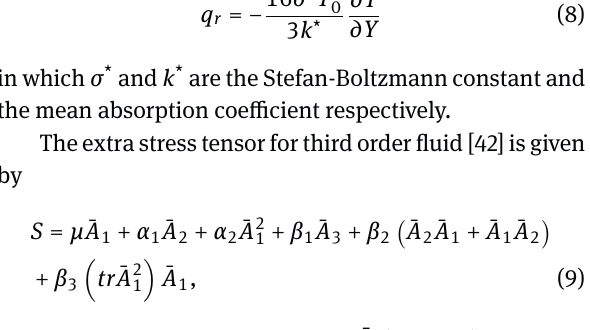
where μ is the dynamic viscosity , ¯ A i ( i = 1, 2) are Rivlin Ericksen tensors and α i ( i = 1, 2) and β i ( i = 1, 2, 3) are material